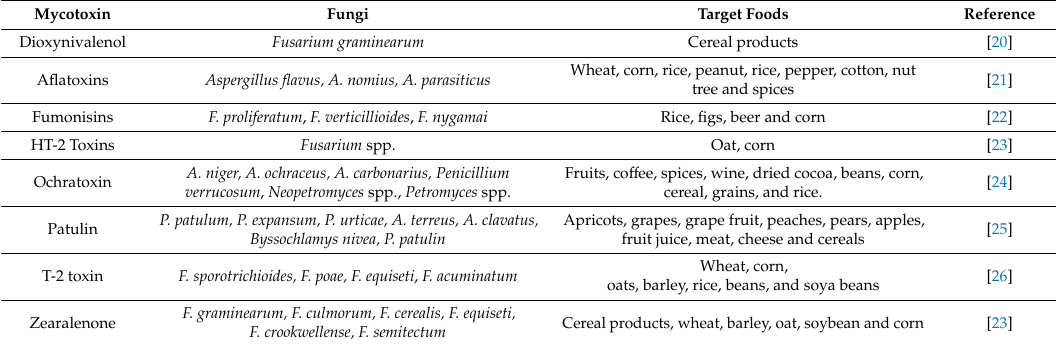
Table 1. Food related mycotoxins and